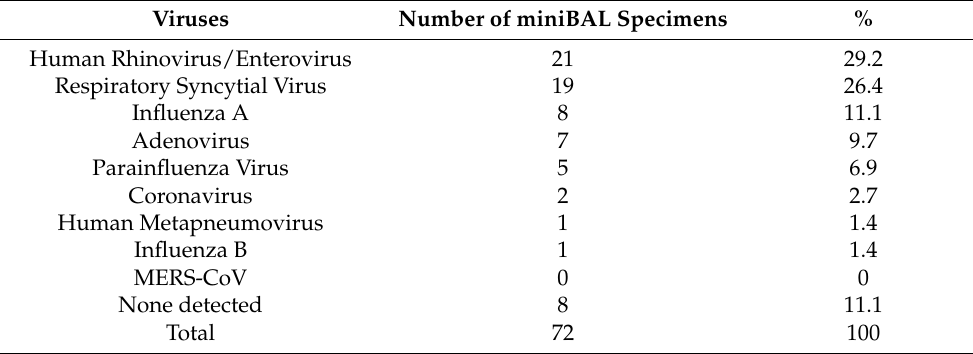
Table 5. The distribution of viruses identified by the FilmArray ® Pneumonia panel plus .